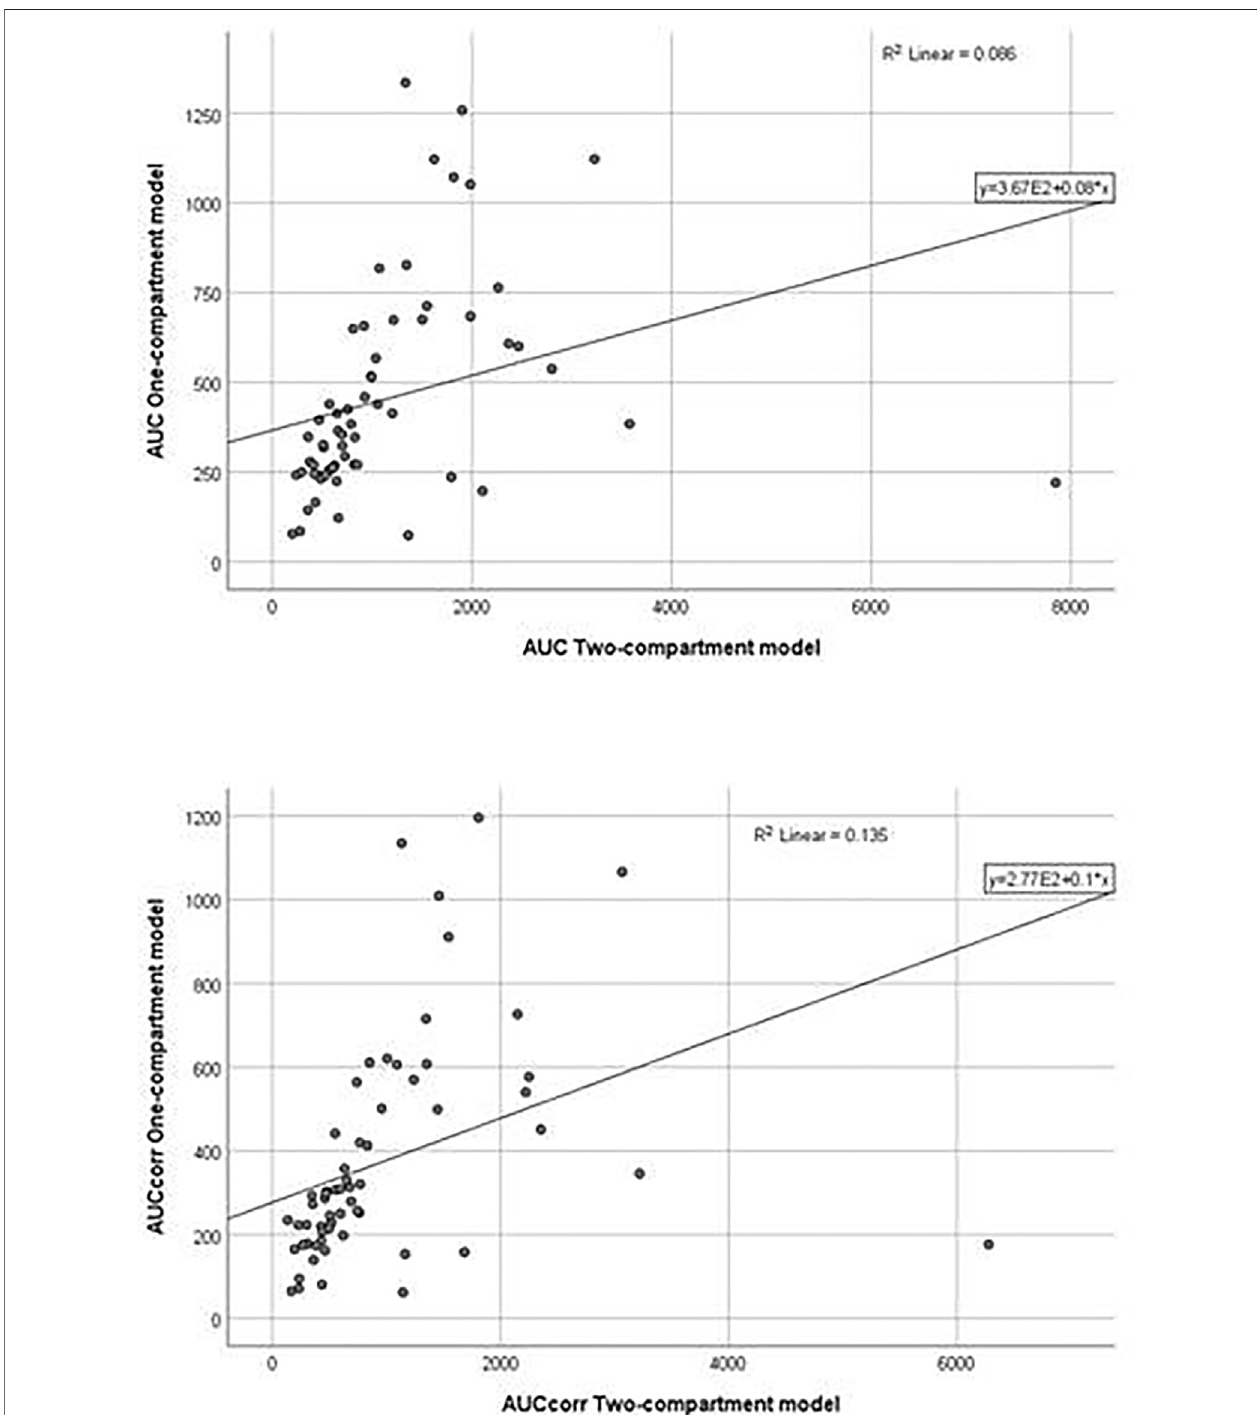
FIGURE 5 | Goodness-of- fi t plots for the one-compartment model versus the two-compartment model (AUC, AUC corr ).